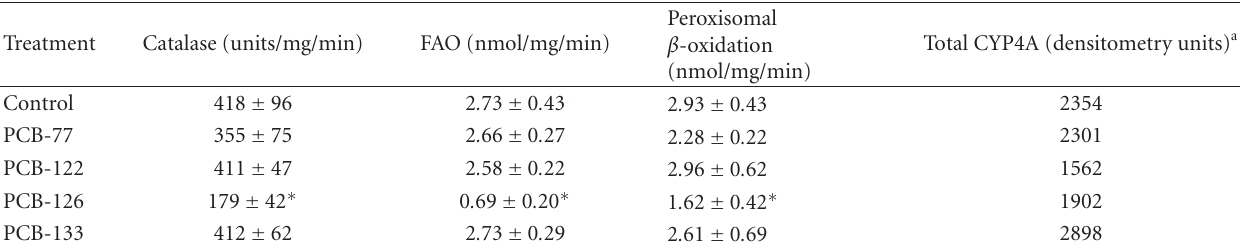
Table 1: E ff ect of PCBs on PPAR α -related enzyme activities and protein levels.